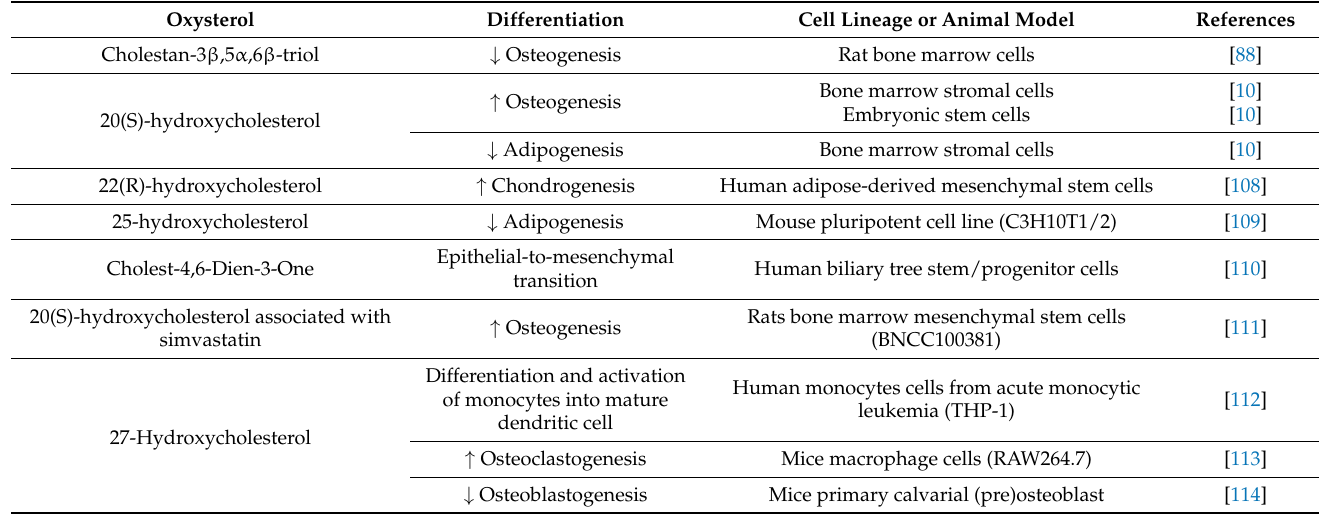
Table 3. Oxysterols and cell